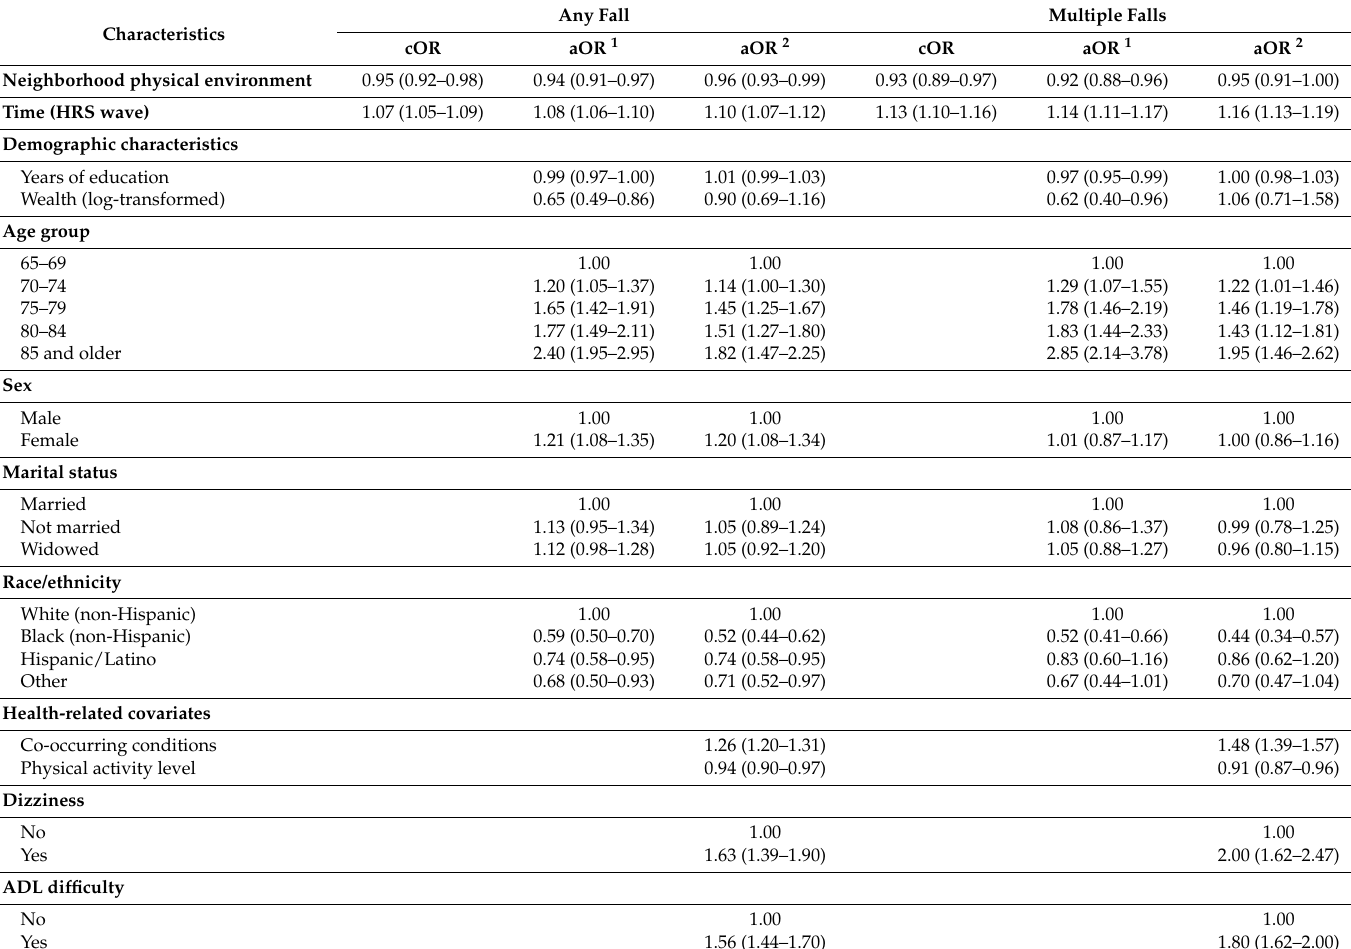
Table 3. Neighborhood physical environment and odds of falls using mixed-effect logistic regression models (robust variance estimation), n =